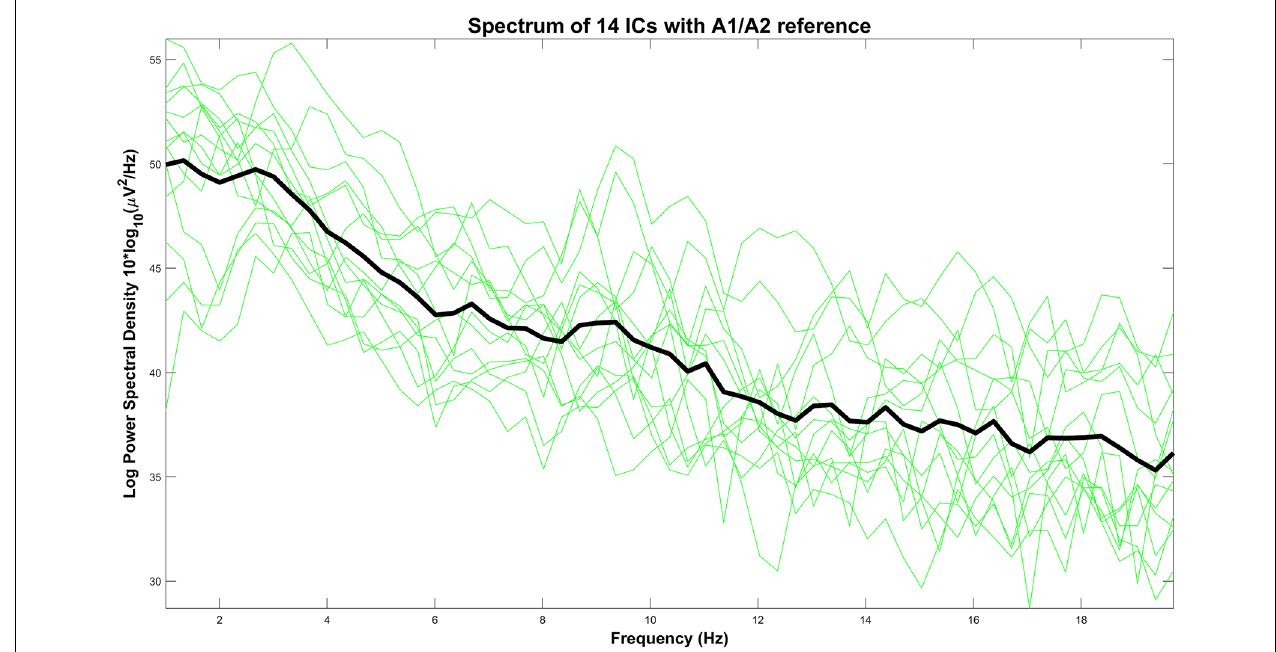
FIGURE 10 | Power spectrum of every IC with A1/A2 as the reference site (green lines) and their average (black